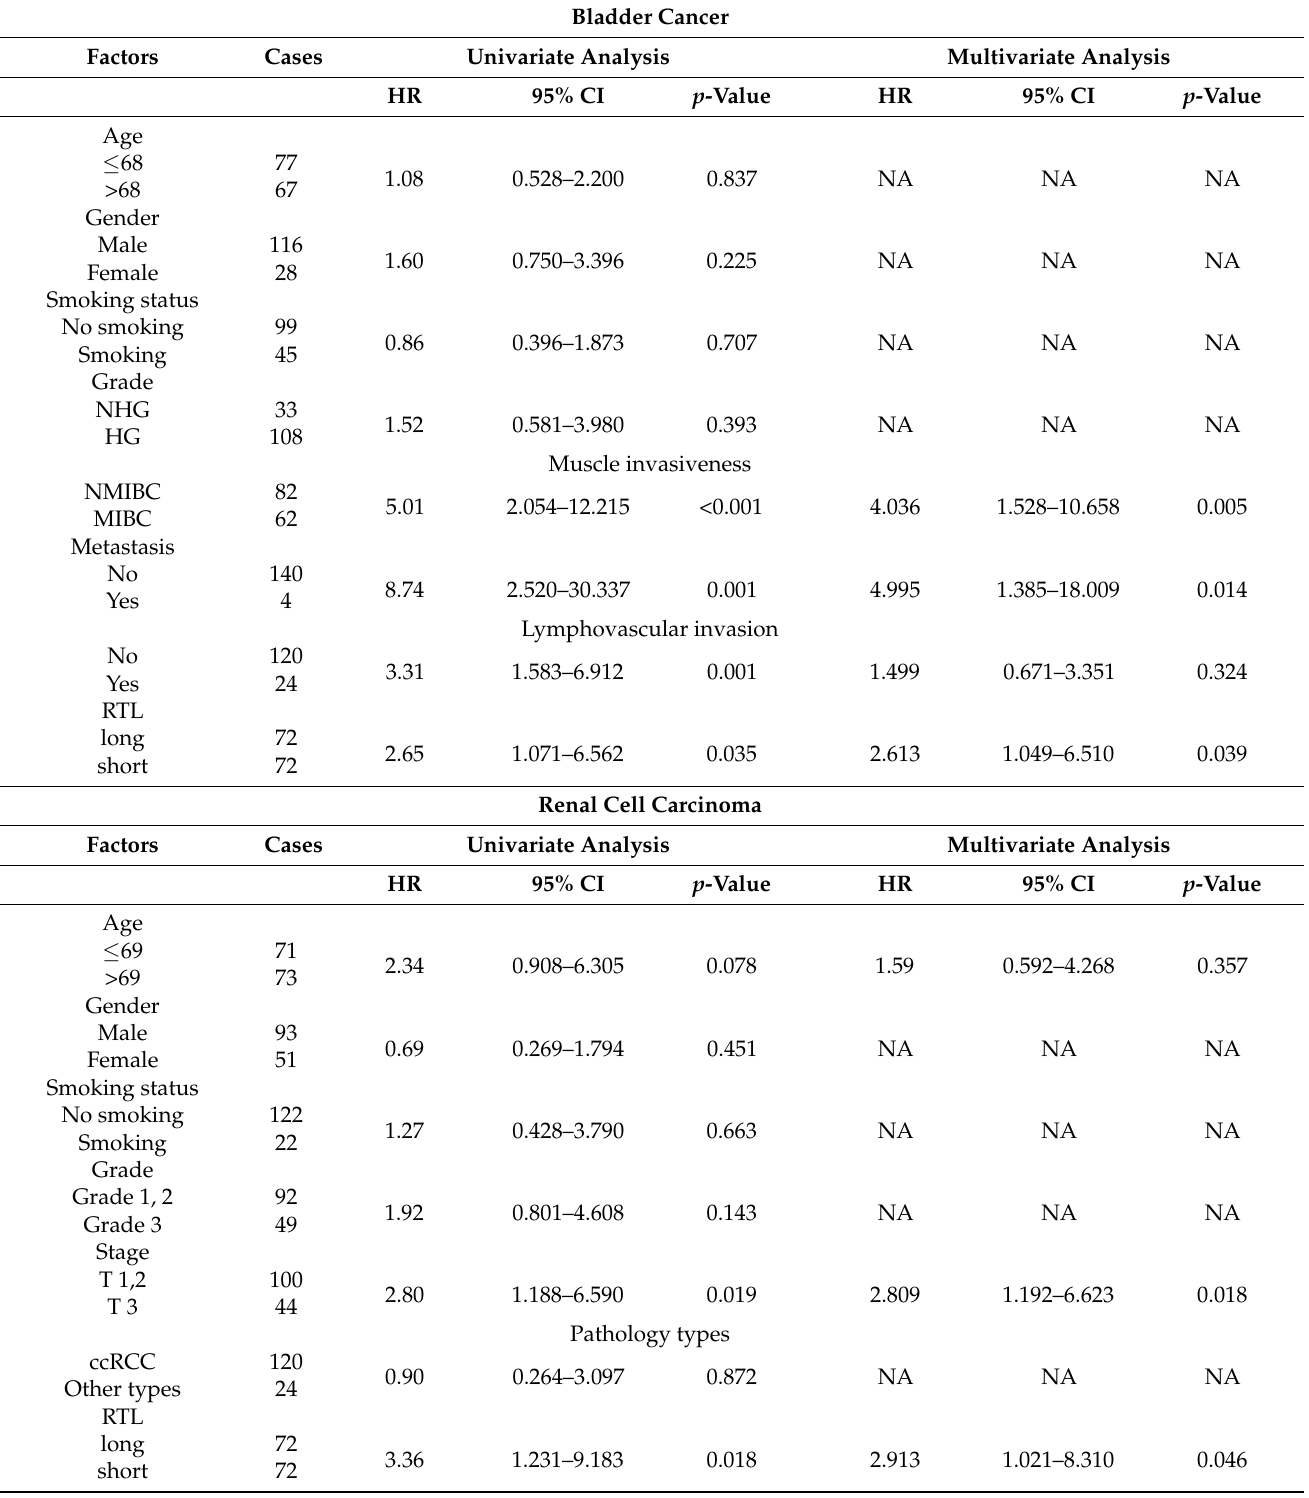
Table 2. Univariate and multivariate Cox regression survival analysis of prognostic factors of bladder cancer and renal cell carcinoma. RTL, relative telomere